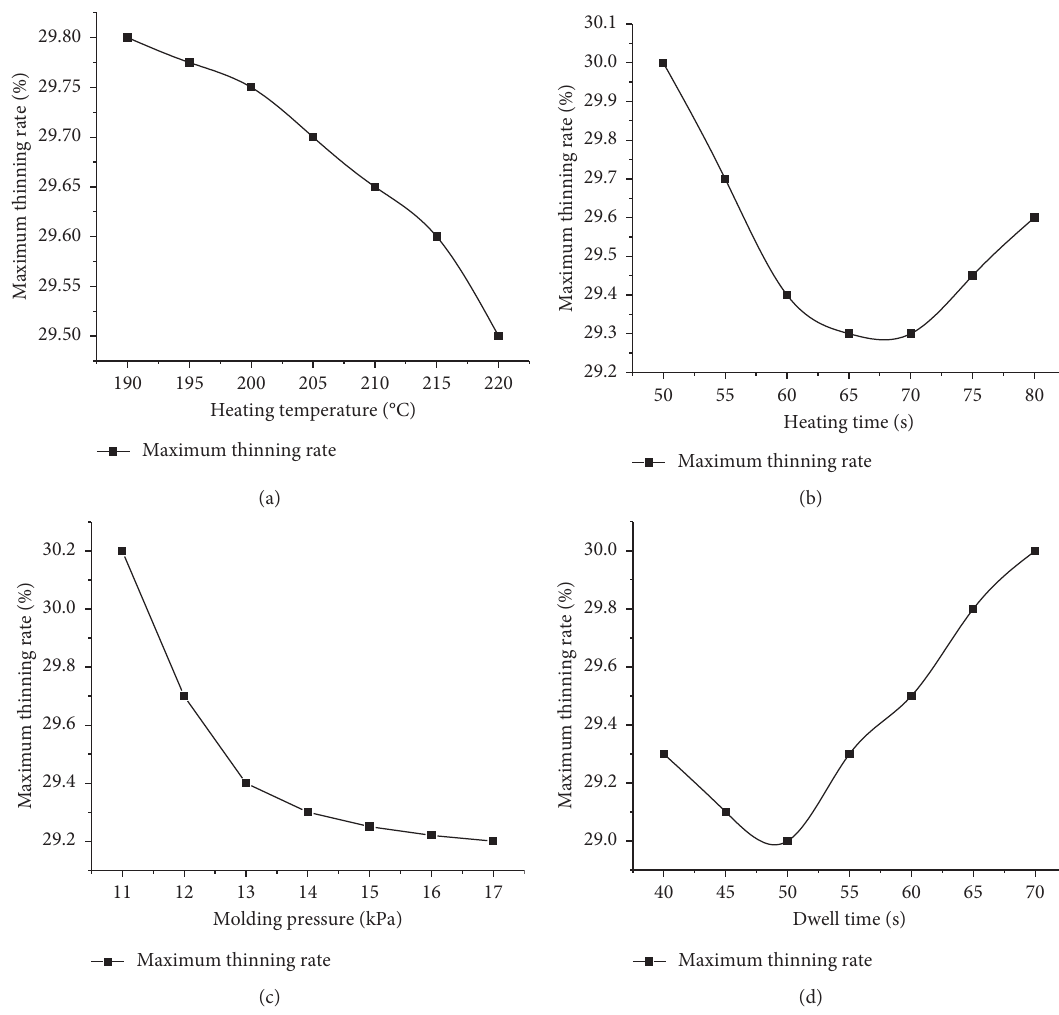
Figure 23: Trend of maximum thinning rate with process parameters. (a) Trend of maximum thinning rate with heating temperature. (b) Trend of maximum thinning rate with heating time. (c) Trend of maximum thinning rate with molding pressure. (d) Trend of maximum thinning rate with dwell